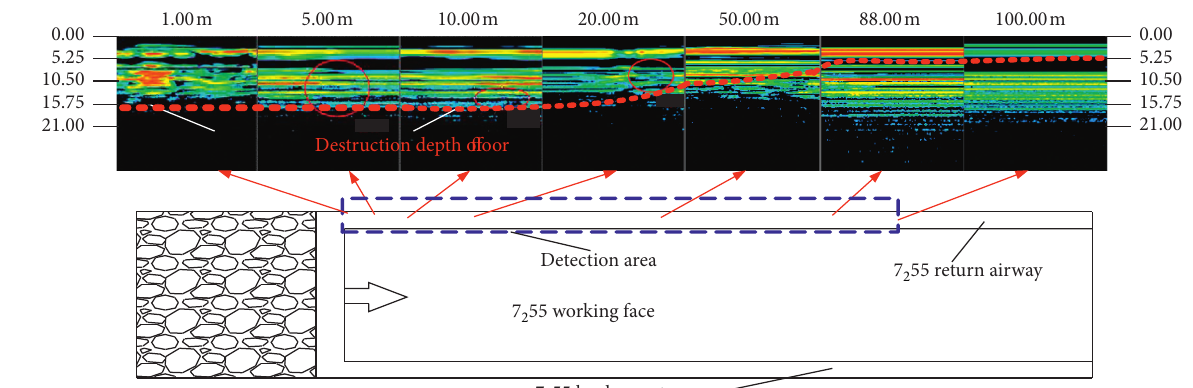
Figure 6: GPR detection results in return